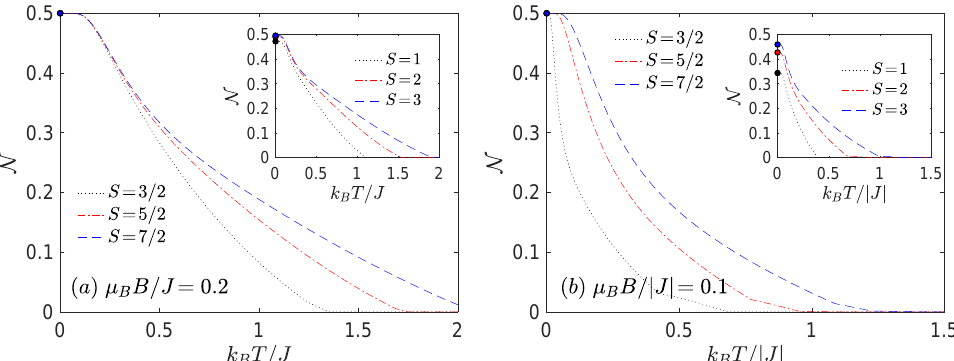
Figure 4. The thermal dependence of the negativity for a few different values of spin magnitudes S calculated at D / J = 1 and ( a ) µ B B / J = 0.2, J > 0 or ( b ) µ B B / | J | = 0.1, J < 0. The choice of model parameters corresponds to the region where the ground state | ( 0 ) ± (cid:105) (half-odd-integer spin S ) or | ( 1/2 ) ± (cid:105) (integer spin S ) are favoured.